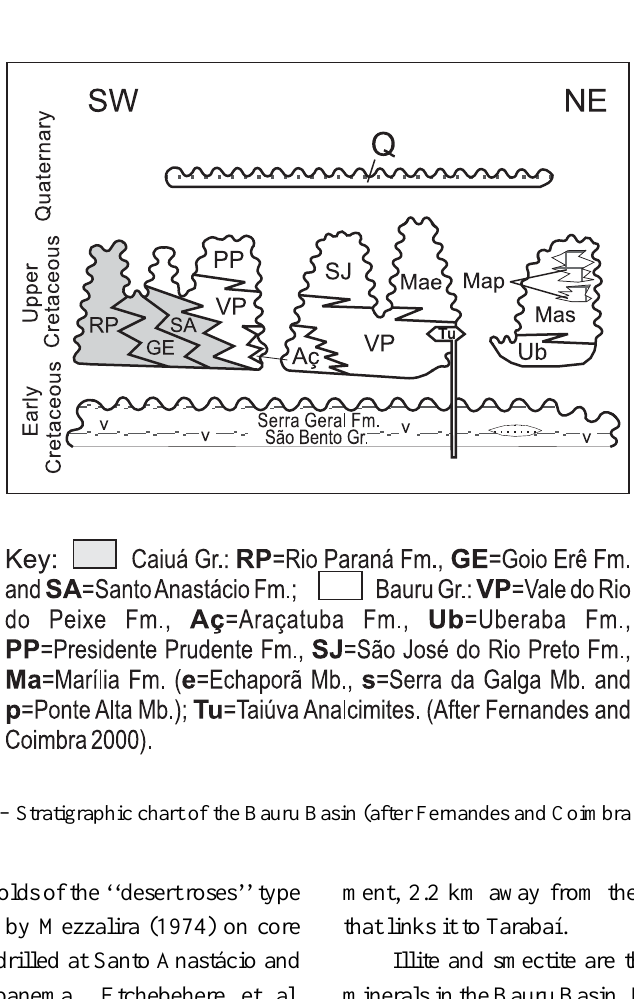
Fig. 2 – Stratigraphic chart of the Bauru Basin (after Fernandes and Coimbra